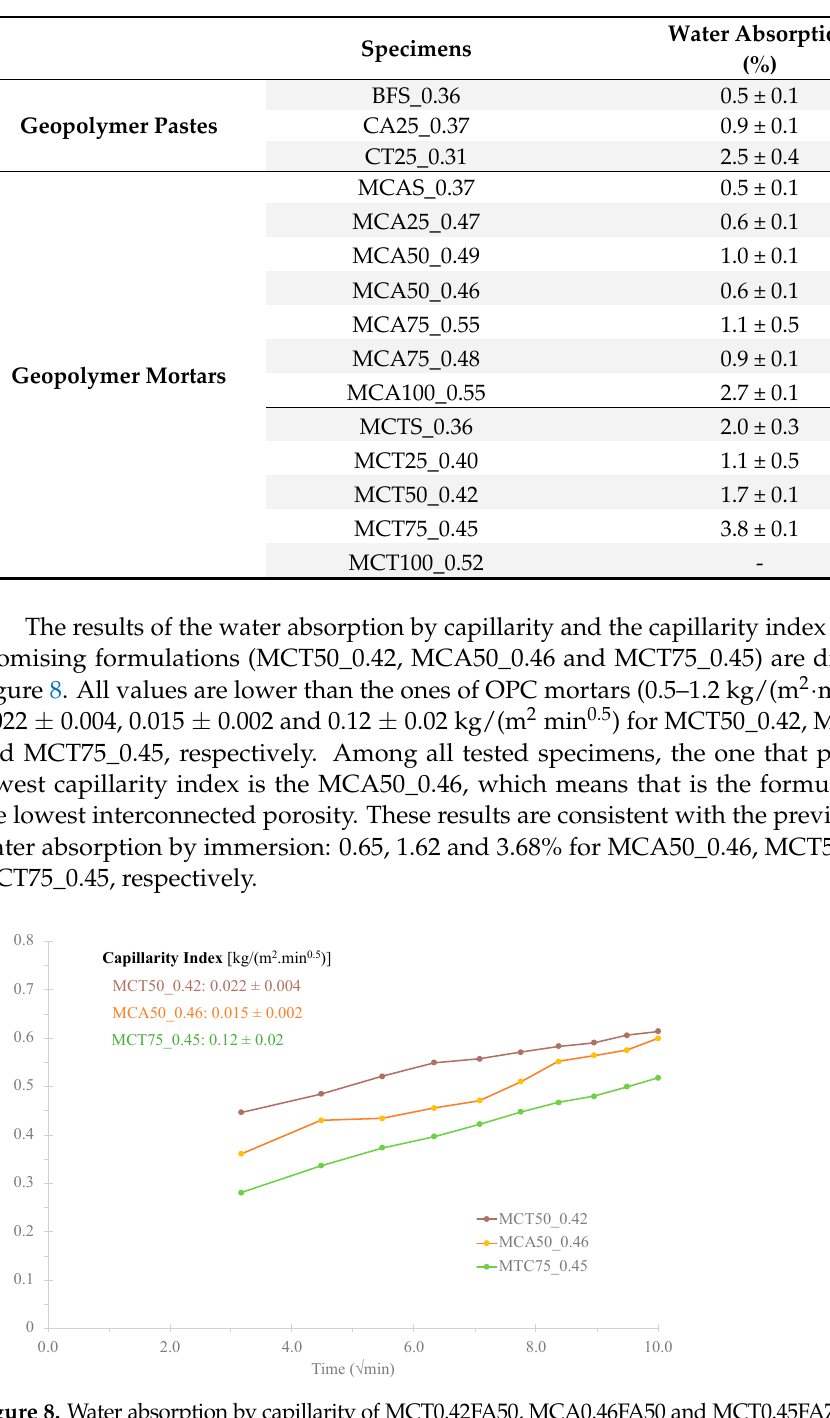
Table 5. Water absorption by immersion of the specimens with 28 days of curing.